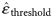
Simulated combined biochemical and biomechanical cartilage degradation.Predicted combined biochemical and biomechanical fixed charge density (FCD) losses in A) intact reference model and B) injury model. Combined biochemical and biomechanical degradation shown at time t = 4 d was simulated with 1 ng/ml of exogenous interleukin-1 and with the degeneration threshold of ε^threshold = 50% of the maximum shear strain. This threshold was chosen to match model predictions and experimental findings.